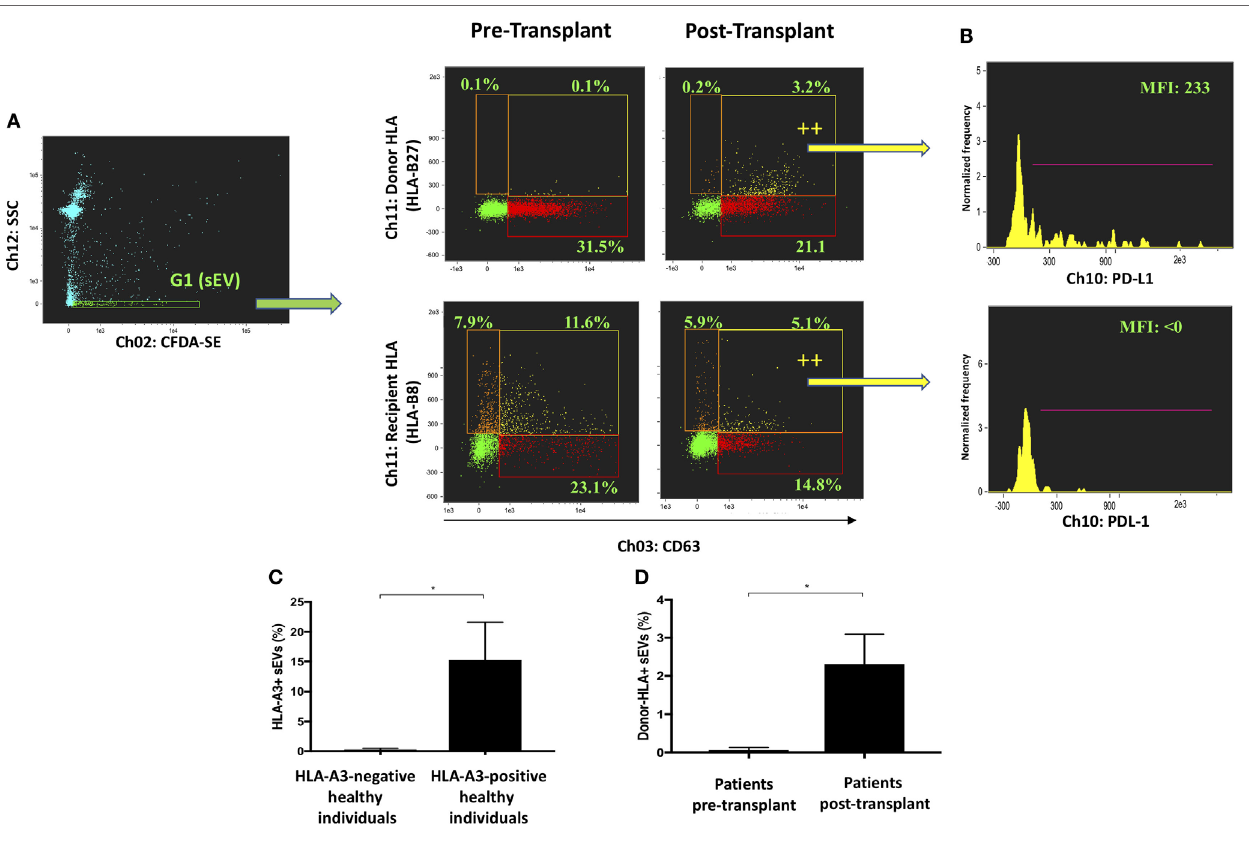
FIgURe 3 | Profiling of circulating exosomes for tissue-specific biomarker discovery and functional analysis (Application 2). (A) Small EVs (sEVs) from an HLA-B27- positive, HLA-B8-negative recipient were gated in G1 before and after receiving a liver allograft from an HLA-B8-positive, HLA-B27-negative donor. Bona fide CD63-positive exosomes were analyzed for their expression of donor and recipient HLA. Donor HLA-bearing exosomes become detectable in circulation after liver transplantation. (B) PD-L1 expression was analyzed in exosomes bearing either donor or recipient HLA and found higher in the former group post-transplantation. (C) Percentage of HLA-A3 positive sEVs were compared between genotypically confirmed HLA-A3 + ( n = 3) and HLA-A3 negative ( n = 3) individuals. (d) Percentage of donor-HLA + sEVs observed pre- and post-liver transplantation, in genotypically confirmed HLA-mismatched liver transplant recipients ( n 3). Data represented as mean ± SD. * P <